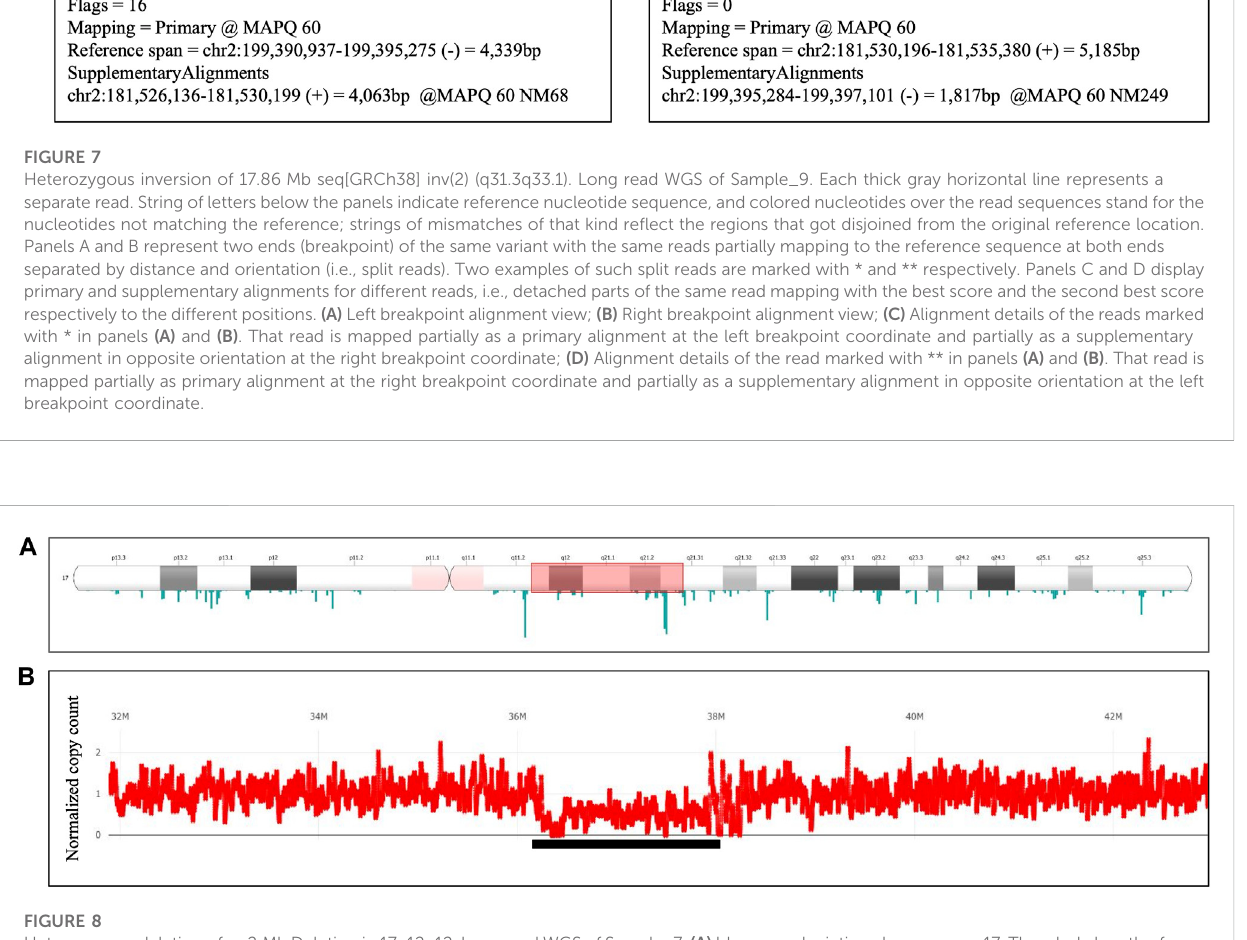
Figure 9; Supplementary Figure S1 show the long read WGS results of a maternal UPD case (UPD(20)mat) for which informative loci were selected to be a reference in the mother and homozygous alternate in the father, based on the prior short-read trio sequencing